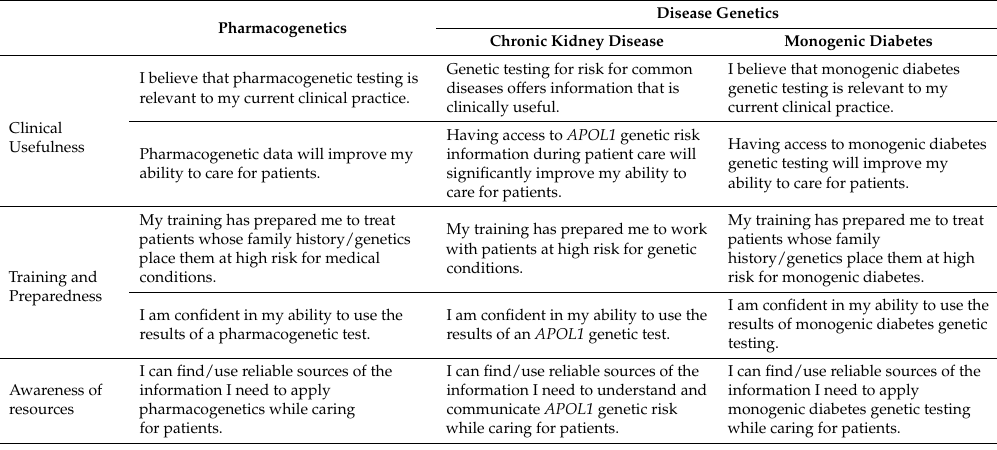
Table 1. Survey tools administered at the Implementing GeNomics In pracTicE (IGNITE) sites for this